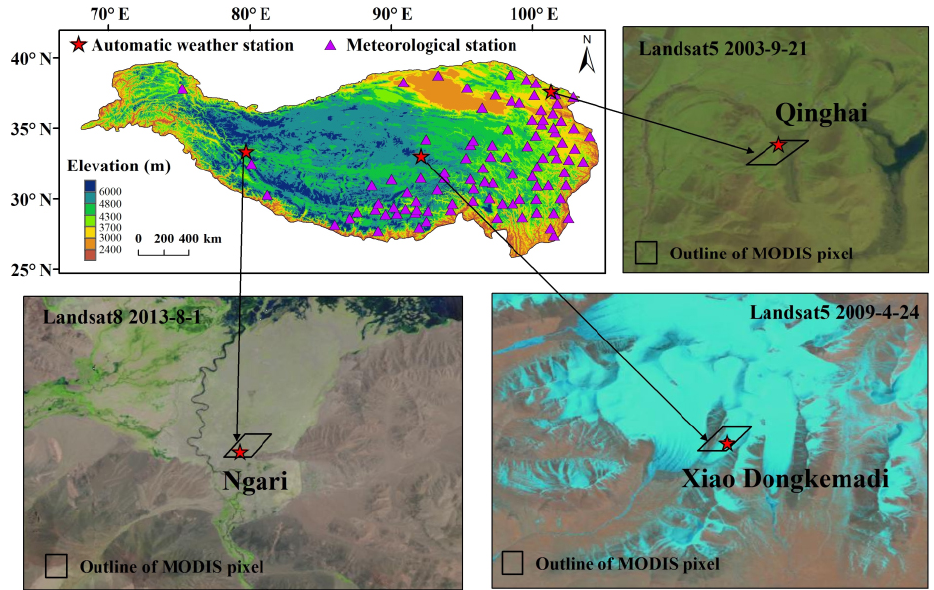
Figure 1. Map of the TP marking AWS and meteorological station locations. Landsat images observed during the time period for data used in this study are also shown in natural color modes with acquired dates. The outline of the MODIS grid is also